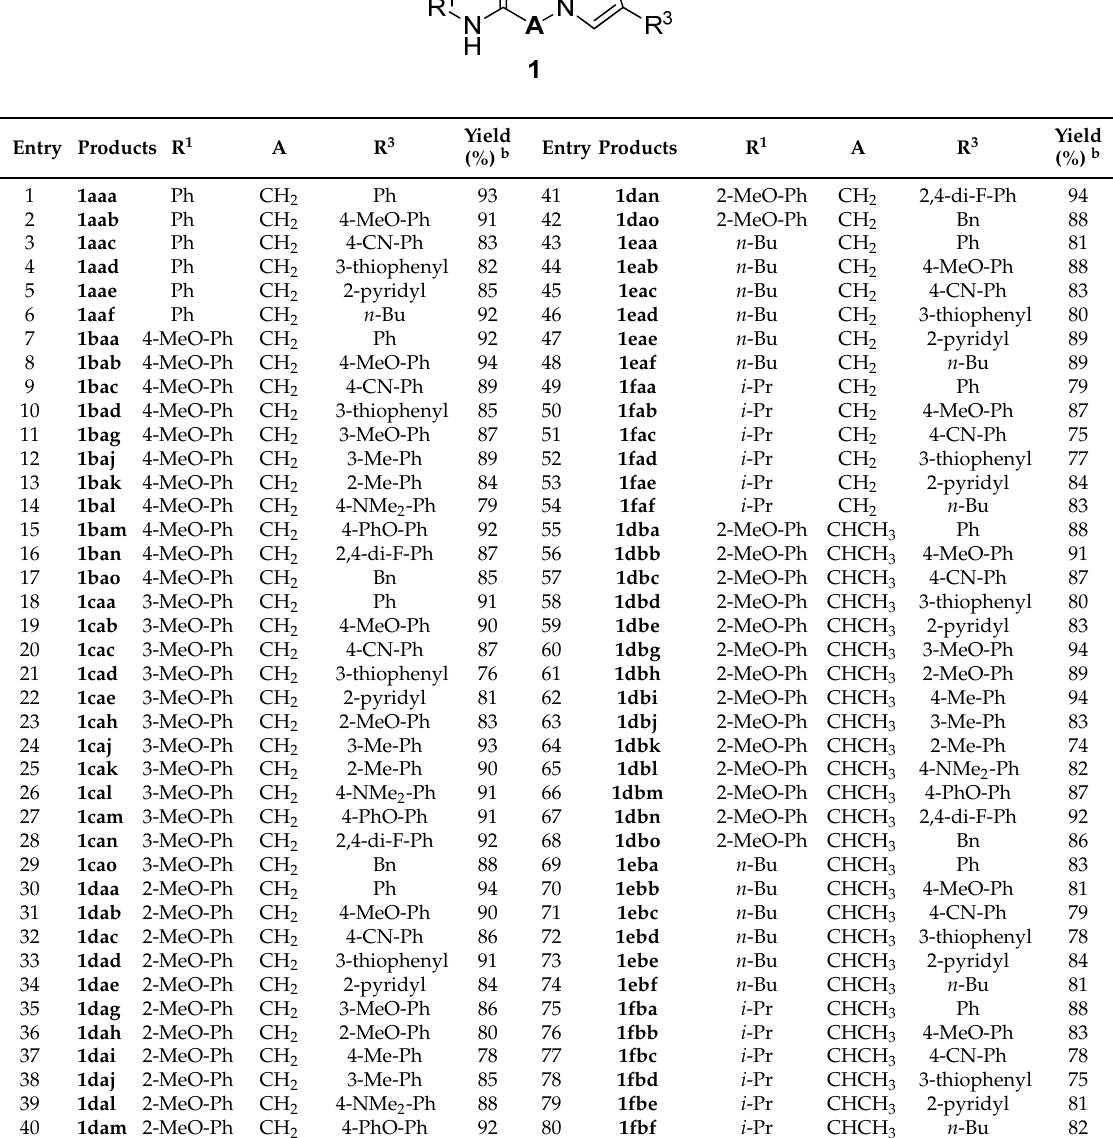
Table 1. Prepared secondary α -1,2,3-triazoloamide derivatives 1 a .